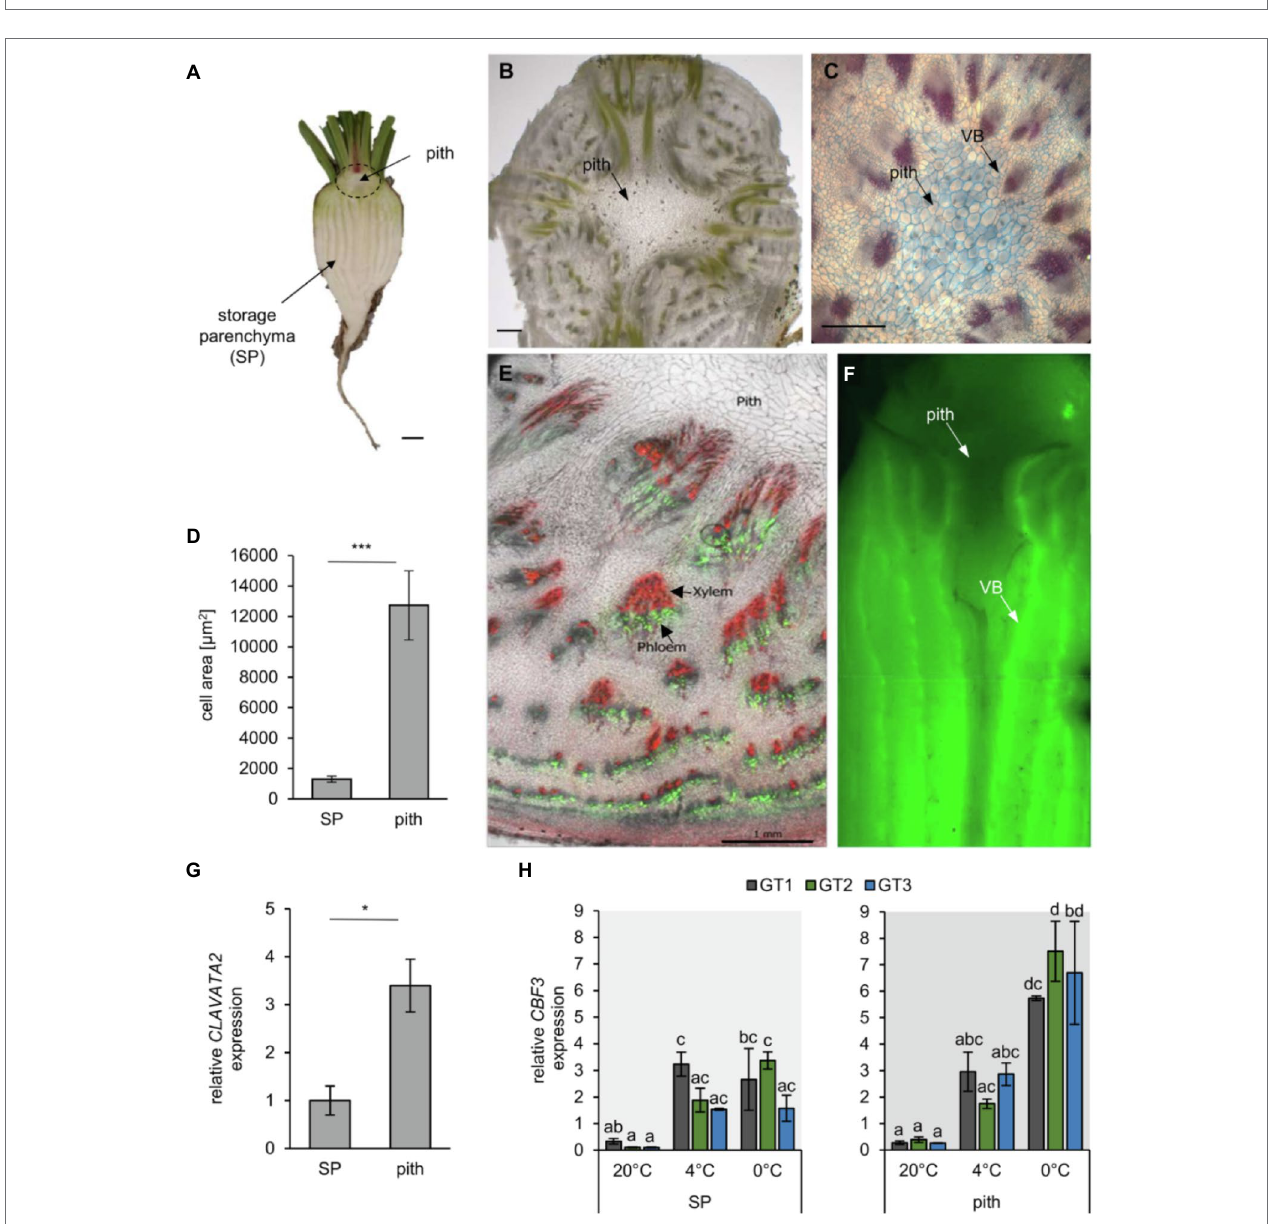
FIGURE 1 | Quantum yield of photosynthesis [Y(II)] and non-photochemical quenching [Y(NPQ)] and non-regulated energy dissipation [Y(NO)] were measured. Temperature intervals are highlighted in white (12 ° C), light grey (4 ° C), or grey (0 ° C). Values represent the mean of three biological replicates. Error bars represent the standard error of the corresponding mean. The same level of significance, calculated via two-way ANOVA with post-hoc Tukey HSD test with p < 0.05, is given in grey letters for FT1, green letters for GT2, and blue letters for GT3. (E) Morphology of sugar beet taproots of genotype GT1 after freezing recovery. Plants were grown at 20 ° C for 13 weeks and afterward were shifted to 12 ° C, 4 ° C and 0 ° C and were retransferred to 20 ° C for 2 weeks after freezing treatment.